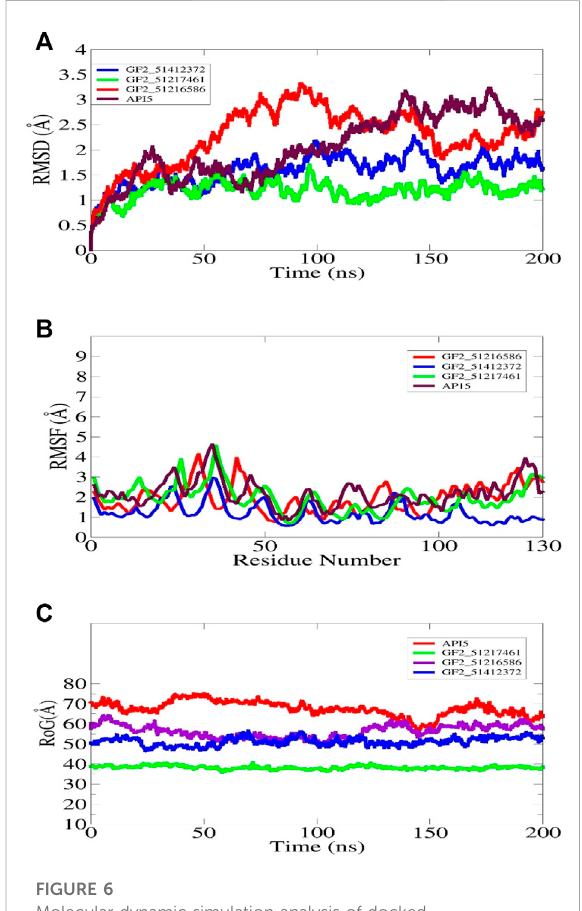
FIGURE 6 Molecular dynamic simulation analysis of docked FGF2 complexes. All the analyses are performed on alpha-carbon atoms of the receptor molecule. The RMSD, RMSF, and RoG plots for shortlisted best binding molecules and control are shown in (A – C) , respectively.